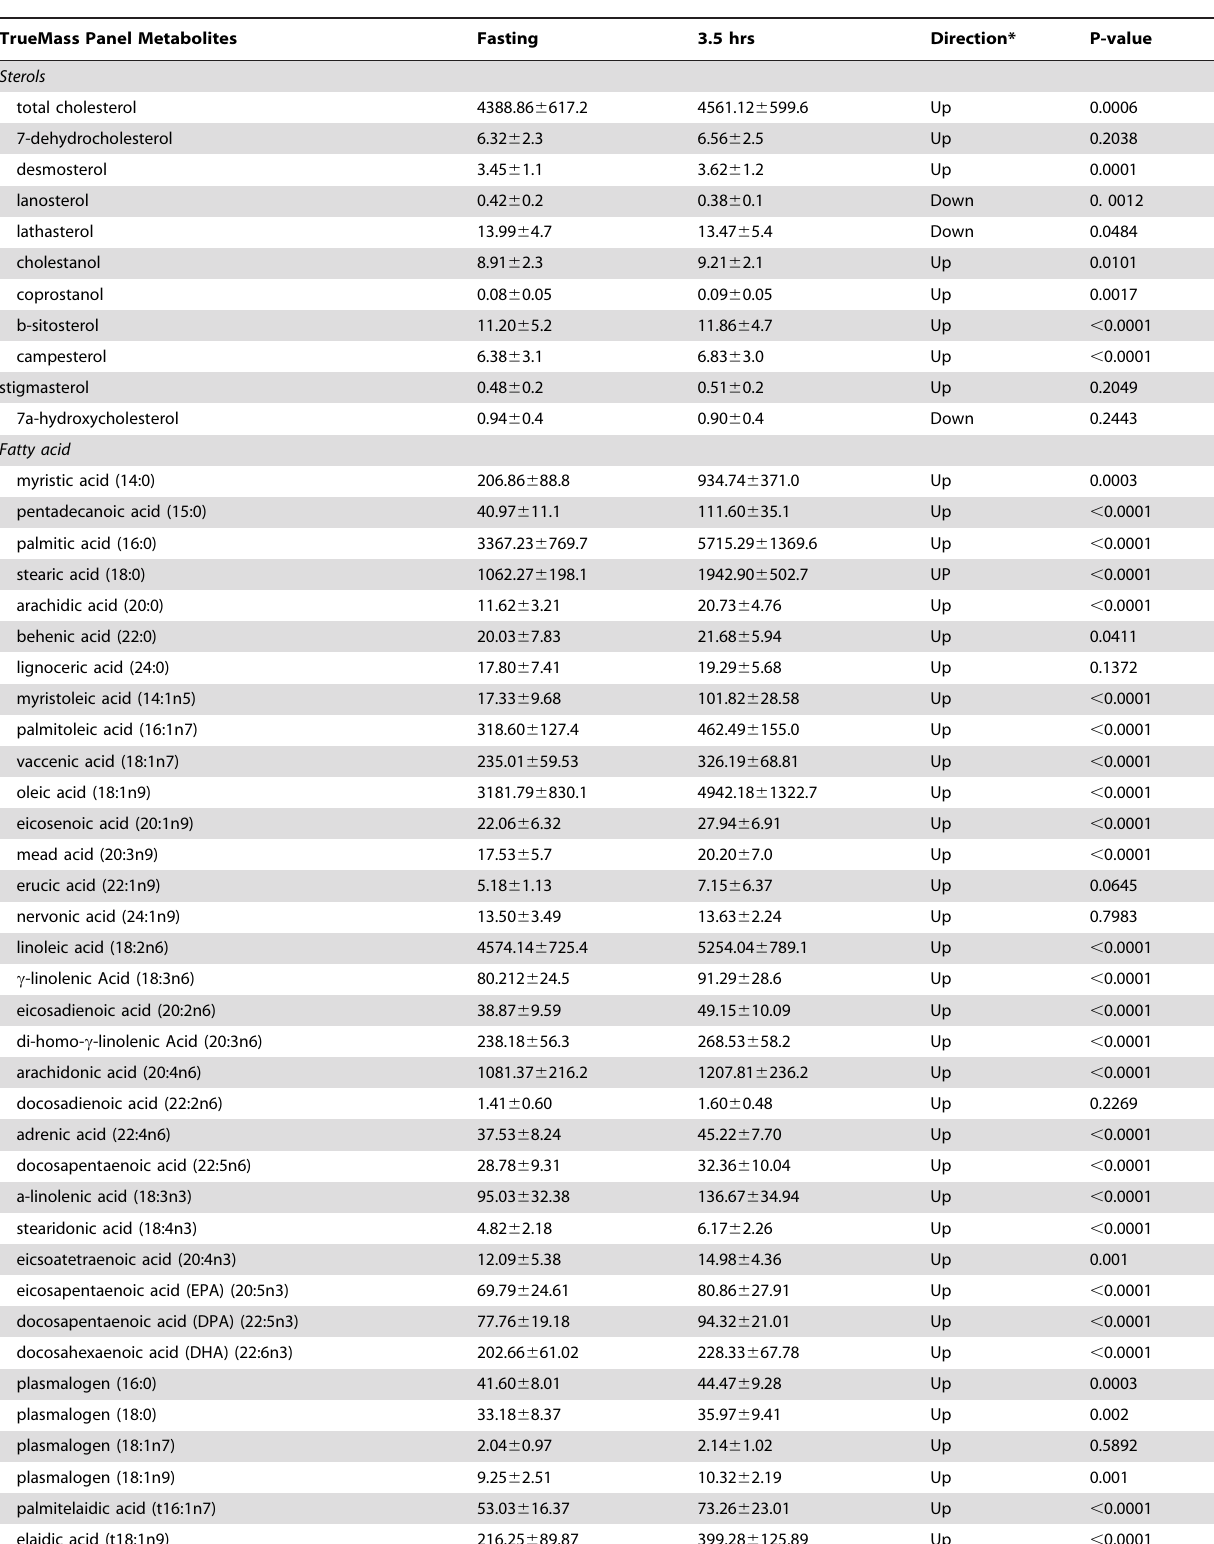
Table 1. Average concentration (nmol/gram of sample) of TrueMass panel metabolites measured at fasting and 3.5 hours after a postprandial lipemia (PPL) challenge for 40 Genetics of Lipid Lowering Drugs and Diet Network Study